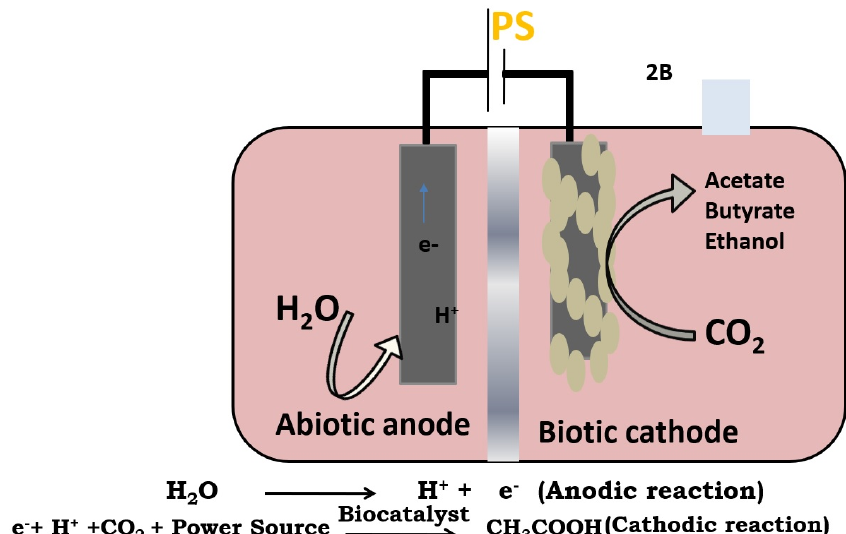
Figure 2. ( A ) A generalised schematic representation of a typical dual-chambered Bioelectrochemical System (BES) depicting its construction and the processes carried out in the system. On the anode, microbial biofilm comprising exoelectrogens oxidises the organic matter. Electrons and protons on being released travel via distinct paths to the cathode, where they are reduced to form H 2 . The anode potential being higher than that of the cathode ensures a non-spontaneous reaction, making it essential to apply an external power supply to facilitate the bioelectrochemical reaction. ( B ) [32–36].